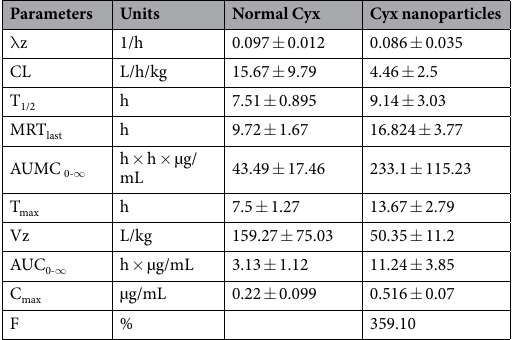
Table 3. Mean plasma pharmacokinetics of Cyx nano-suspension and normal Cyx in Beagle dogs following oral delivery @ 40 mg/kg. λ z, elimination rate constant; T 1/2 , elimination half-life; AUMC 0- ∞ , area under first moment curve; CL, clearance rate; T max , time to reach maximum concentration; C max , maximum concentration of drug; AUC 0- ∞ , area under plasma concentration-time curve; VZ, volume of distribution; MRT last , mean resident time; F, bioavailability. Data are presented as mean ± SD (standard deviation), n =